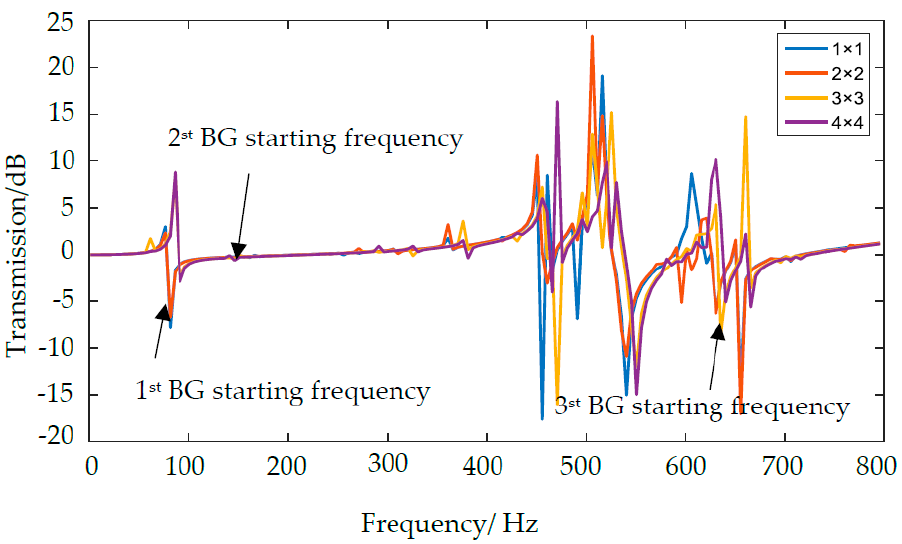
Figure 8. The transmission spectra of N 1 , N 2 , N 3 , and N 4 .